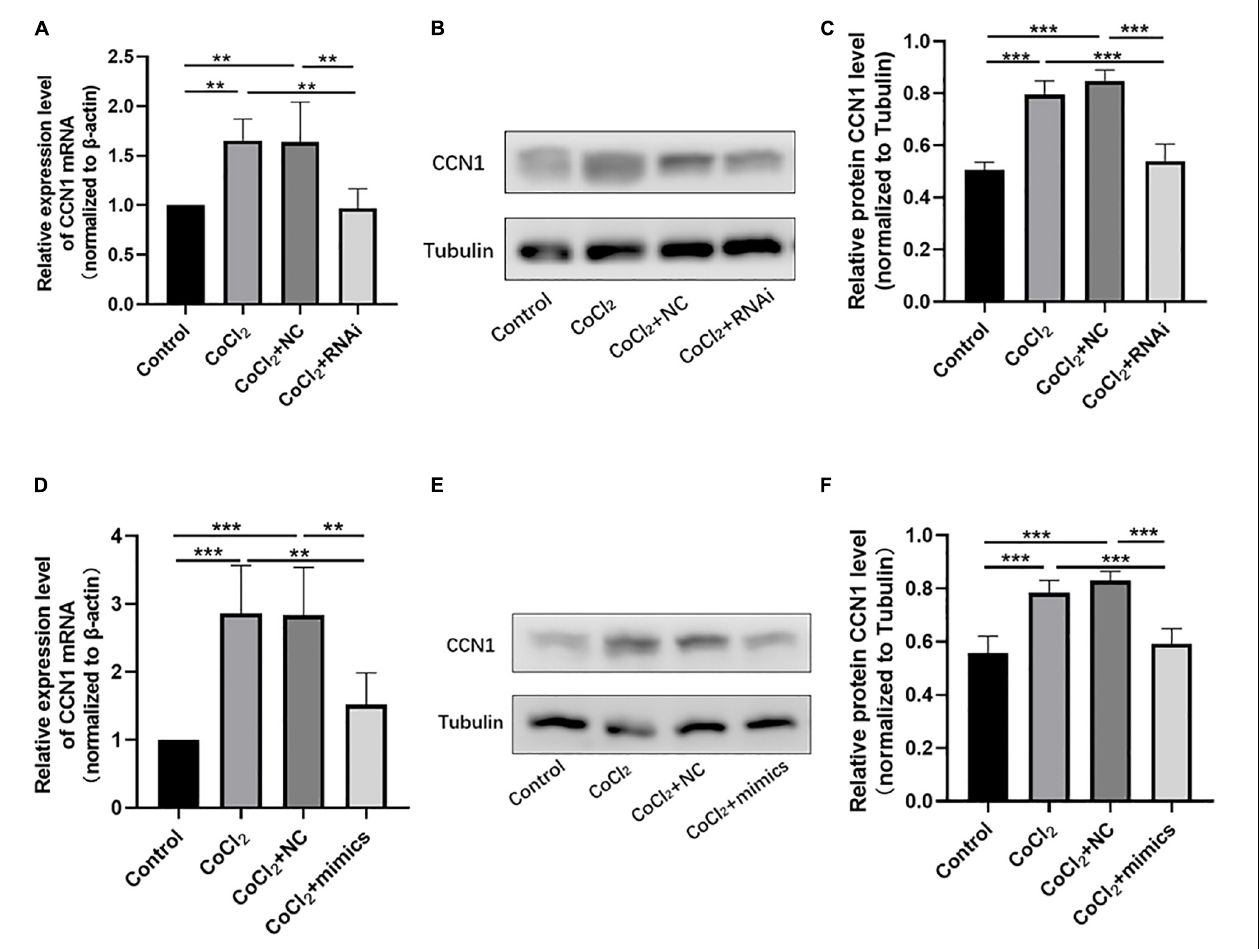
FIGURE 5 | Knocking down TUG1 and overexpressing miR-145-5p inhibits CCN1 expression. (A) CCN1 mRNA expression level (mean ± SD, n = 5). ** P < 0.01. (B) Western blot results of CCN1 expression. (C) Quantitative analysis of band intensities from Western blots shown in (B) (mean ± SD, n = 5). *** P < 0.001. (D) CCN1 mRNA expression level (mean ± SD, n = 5). *** P < 0.001, ** P < 0.01. (E) Western blot results of CCN1 expression. (F) Quantitative analysis of band intensities from Western blots shown in (E) (mean ± SD, n = 5). *** P <